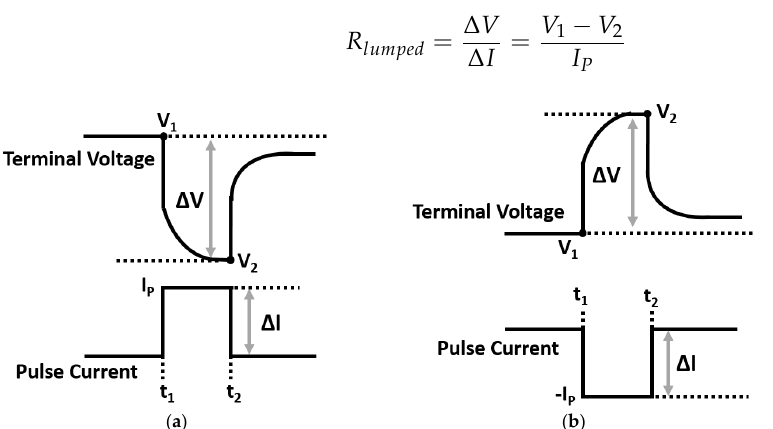
Figure 6. ( a ) Terminal voltage response to a pulse discharging current. ( b ) Terminal voltage response to a pulse charging current.